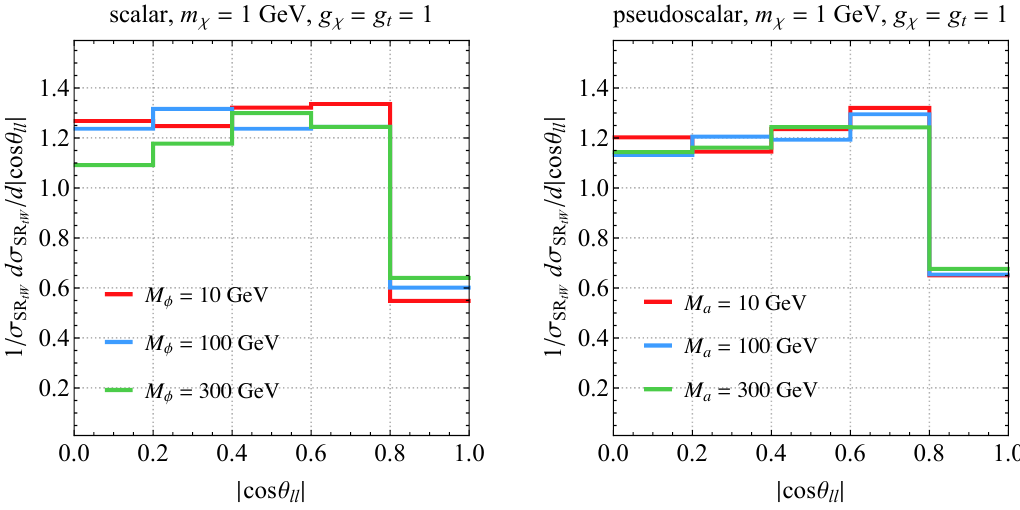
Figure 4 . Normalised j cos (cid:18) ll j distributions corresponding to tW + E miss quent decays t ! bW ! bl(cid:23) and W ! l(cid:23) . The shown results correspond to pp collisions at 14 TeV and adopt apart from C em > 150 GeV the experimental selections SR tW as given in table 1. The parameter choices of the scalar (left) and pseudoscalar (right) s -channel DM simpli(cid:12)ed models are indicated in the